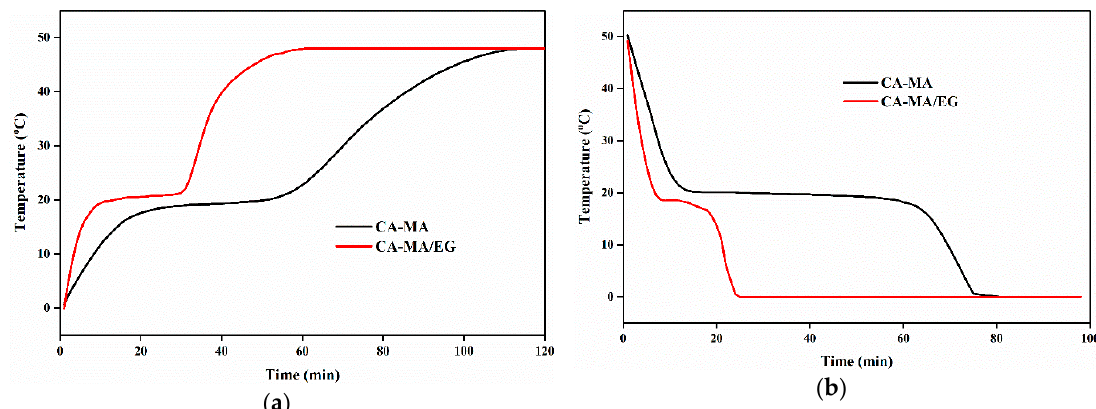
Figure 4. Melting ( a ) and freezing ( b ) graphs of CA–MA and CA–MA/EG.